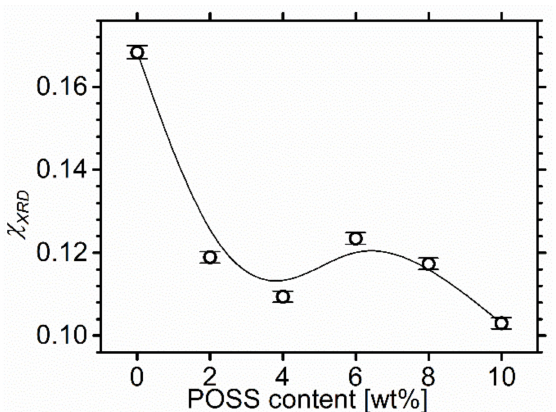
Figure 4. A measure of the degree of crystallinity of the hard domains, as calculated by XRD data. Details of the calculation in text. Lines are guides to the eye.